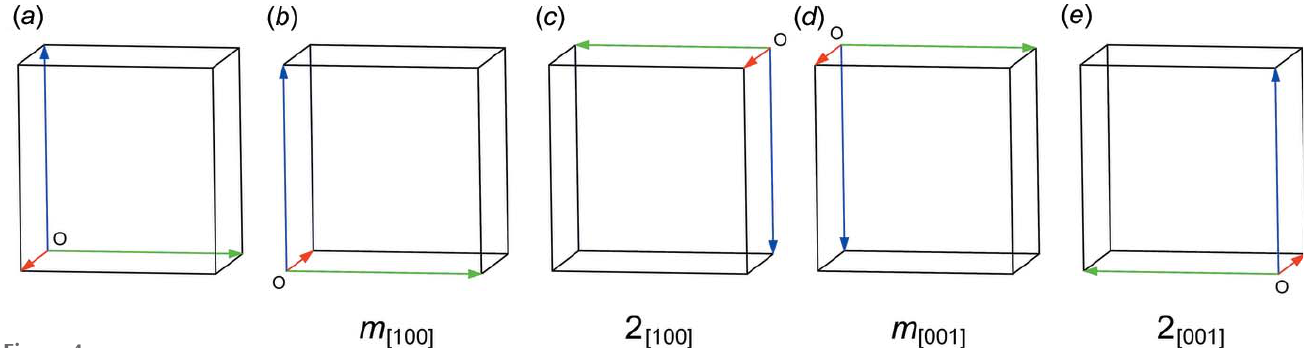
Figure 4 ( a ) Unit-cell axes for XUBNIR (red = a , green = b , blue = c ), and after transformation by: ( b ) a mirror plane perpendicular to the a axis, ( c ) a twofold rotation about the a axis, ( d ) a mirror plane perpendicular to the c axis, ( e ) a twofold rotation about the c axis. All five of the unit-cell ‘boxes’ superimpose because (cid:2) ’ 90 (cid:3) . Note that the mirror operations change the right-handed coordinate system to left handed, whereas the twofold rotations preserve the handedness. Diagrams generated using Mercury (Macrae et al. , 2020).